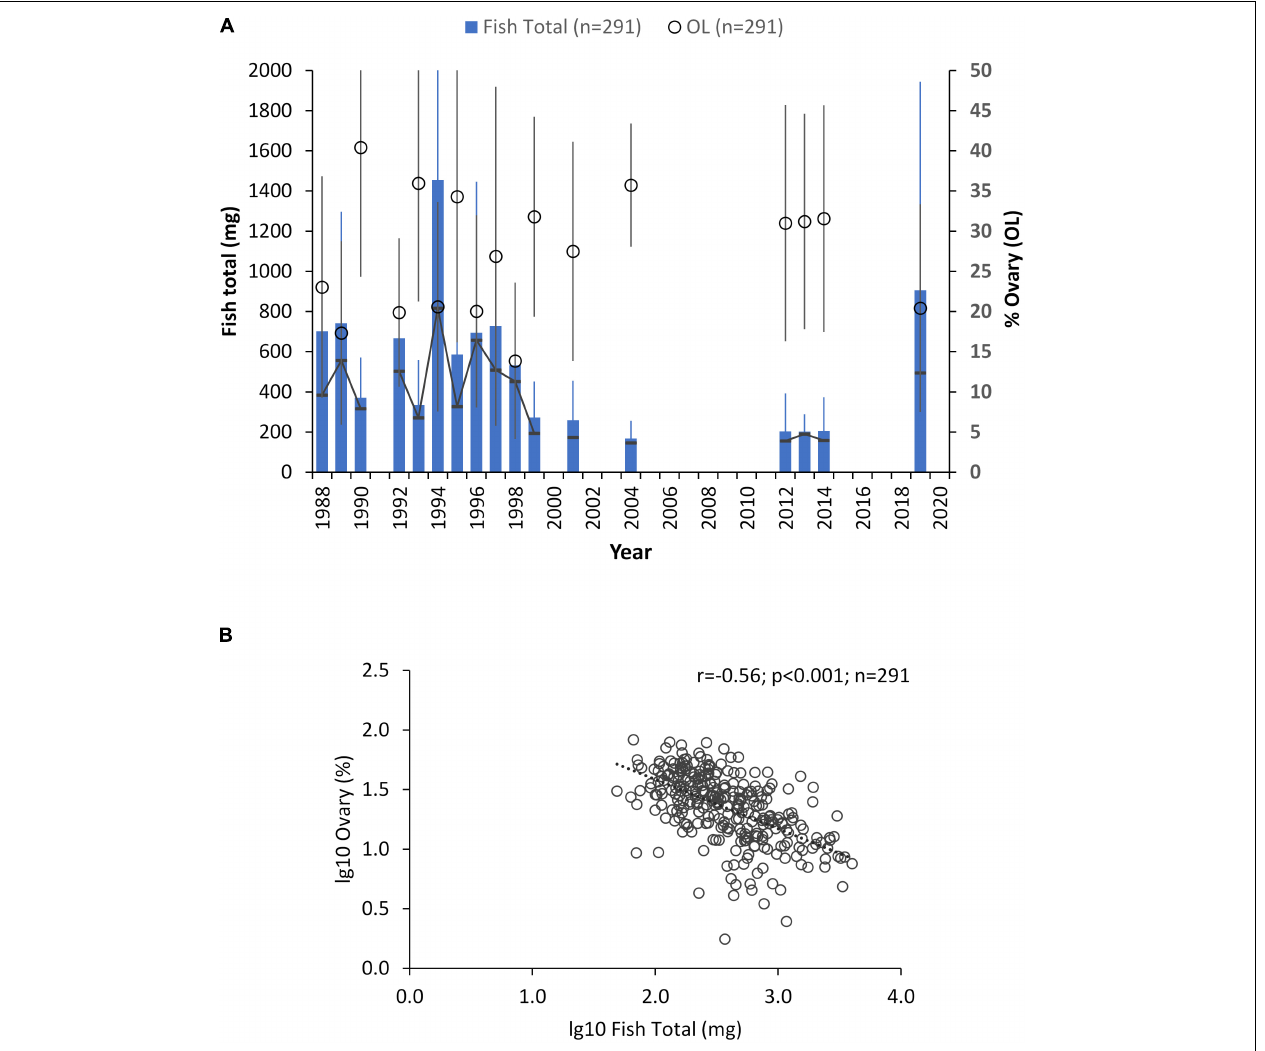
FIGURE 4 | (A) The total amount of lipids in spawning Baltic herring females (Fish Total, mg; columns) and the proportion of lipids in their ovary as % of total lipids in fish (% Ovary (OL); open circles) during 1988–2019. Mean and standard deviation in the samples; the line with (-) -symbols indicates the median value of Fish